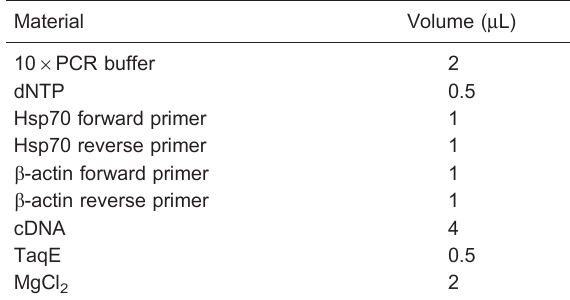
Table 1. PCR reaction system